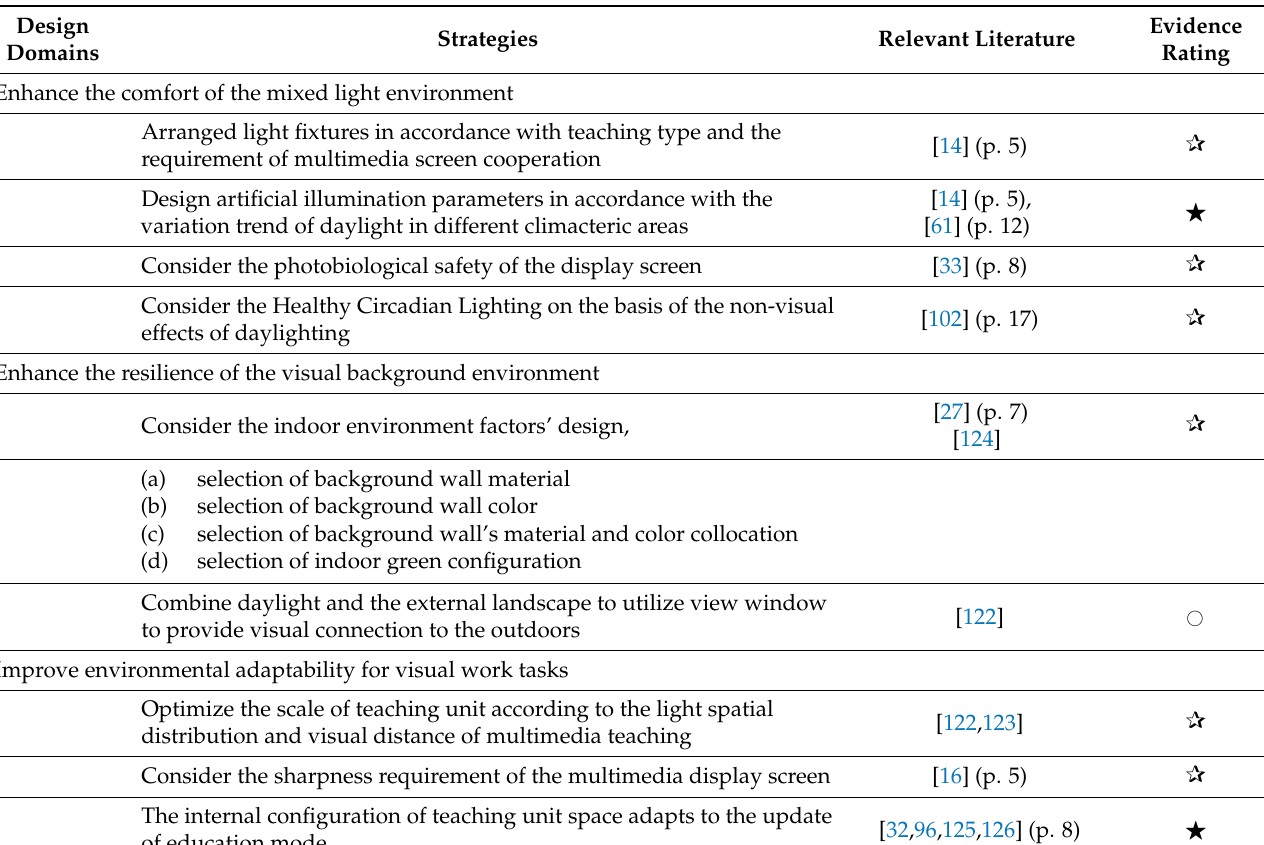
Table 3. Visual health design guidelines for school